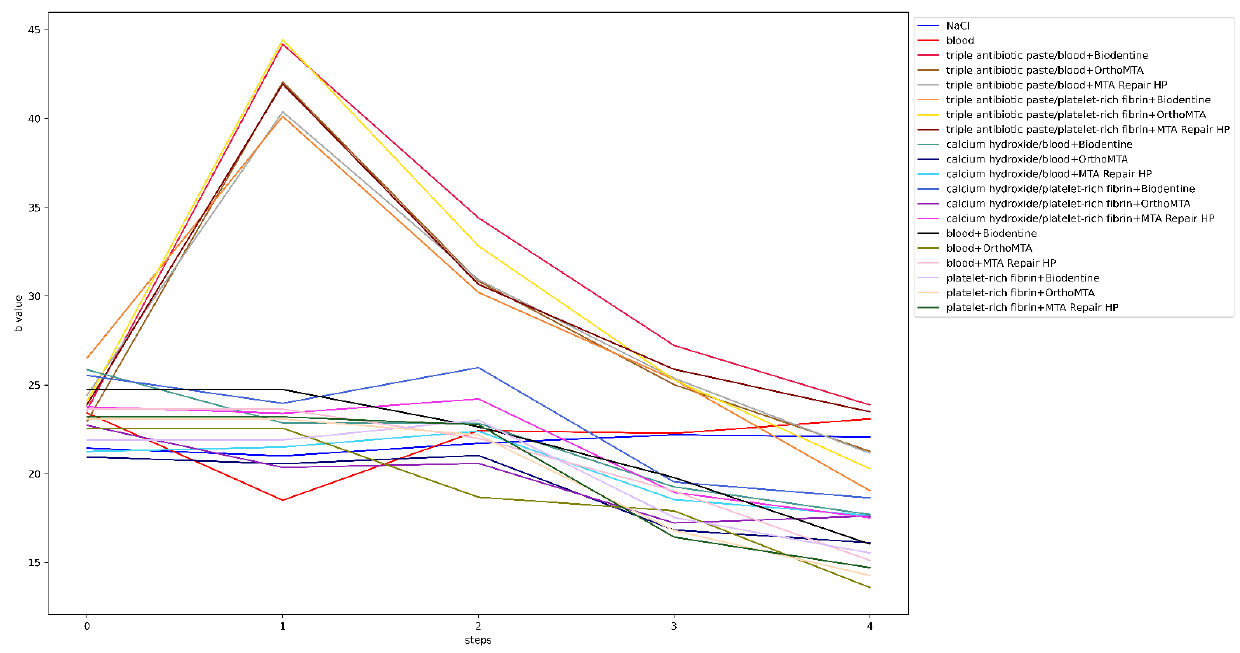
Figure 7. Values of a for all groups and steps .